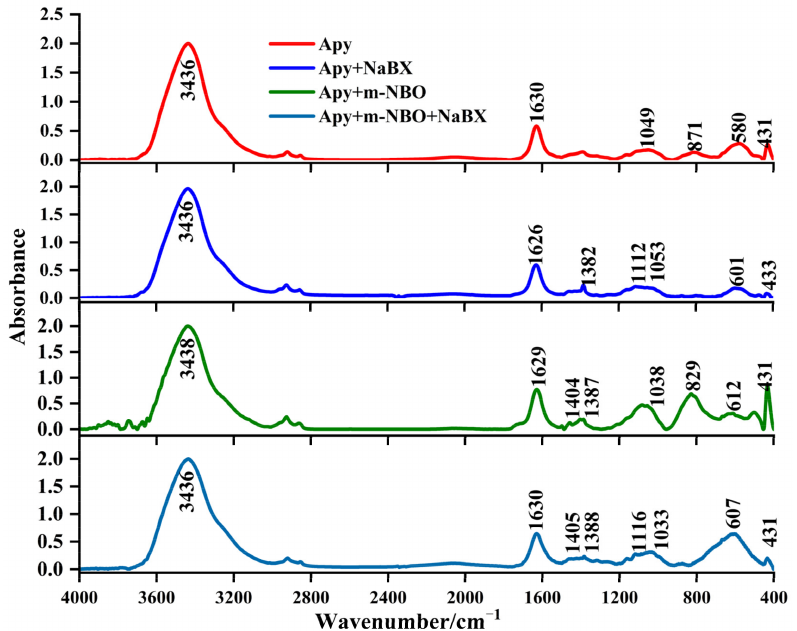
Figure 5. FTIR of arsenopyrite after interaction with m-NBO and NaBX; pH = 11.5, C (m-NBO) = 50 mg · L − 1 , C (NaBX) = 1.6 × 10 − 3 mol · L − 1